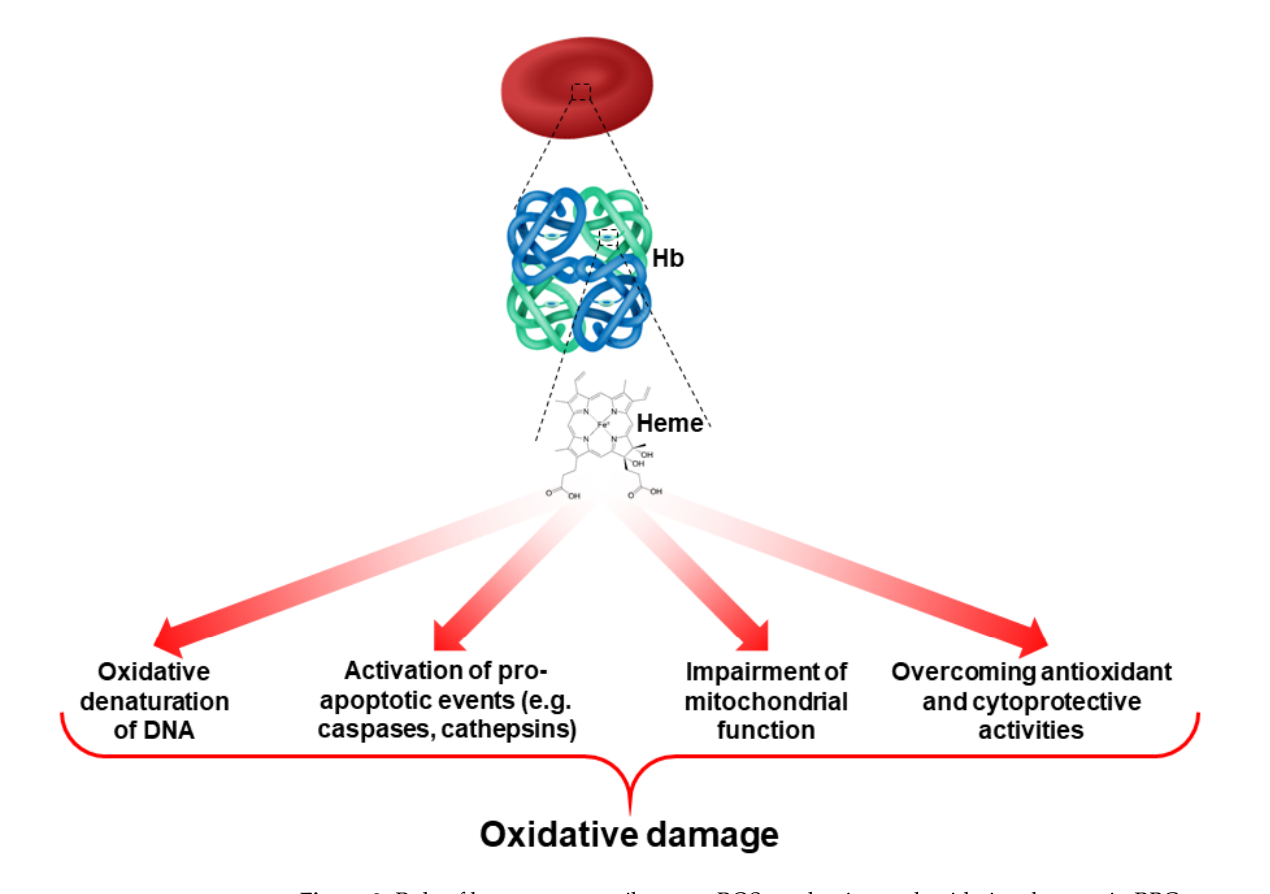
Figure 2. Role of heme as a contributor to ROS production and oxidative damage in